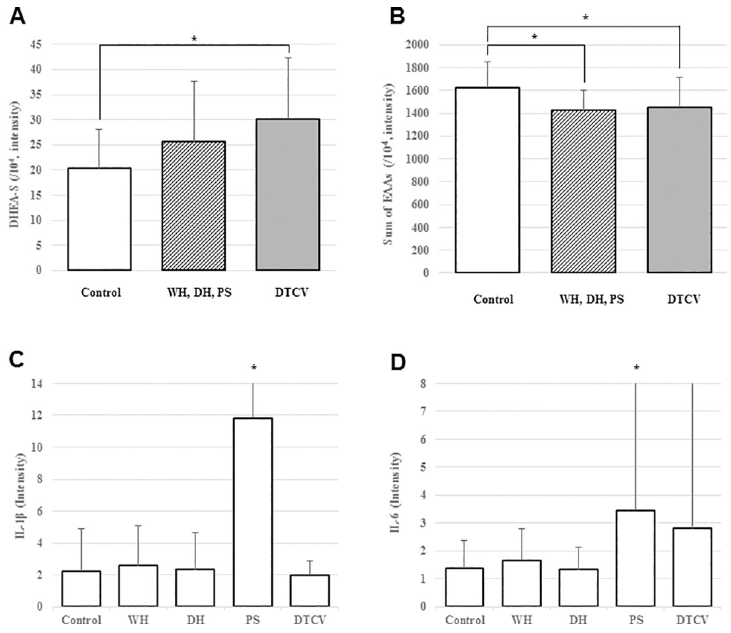
Fig 2. Intensity of DHEA-S, sum of EAAs, IL-1 β , and IL-6 in control and PI groups. ( A, B) Female subjects in the control group vs. female subjects in the WH, DH, and PS group vs. female subjects in the DTCV group. (C, D) Comparison between the control group and other PI